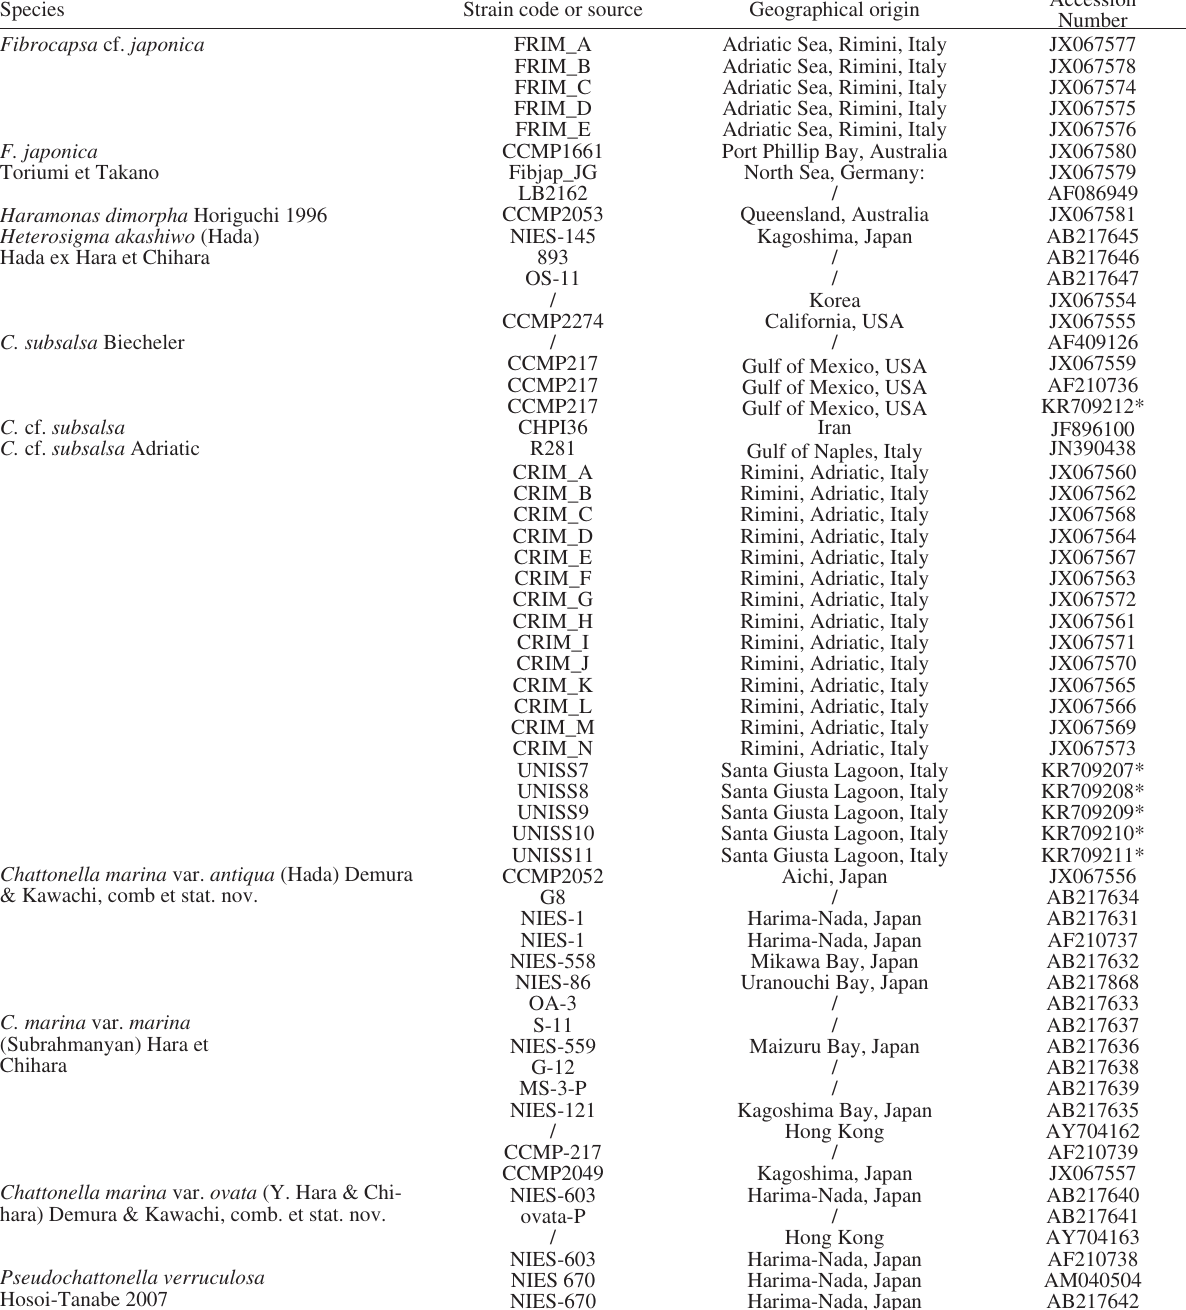
Table 5. – List of the species, strains, geographical origin and GenBank accession numbers of species used in the LSU rDNA phylogenetic tree. * obtained in this study. Species Strain code or